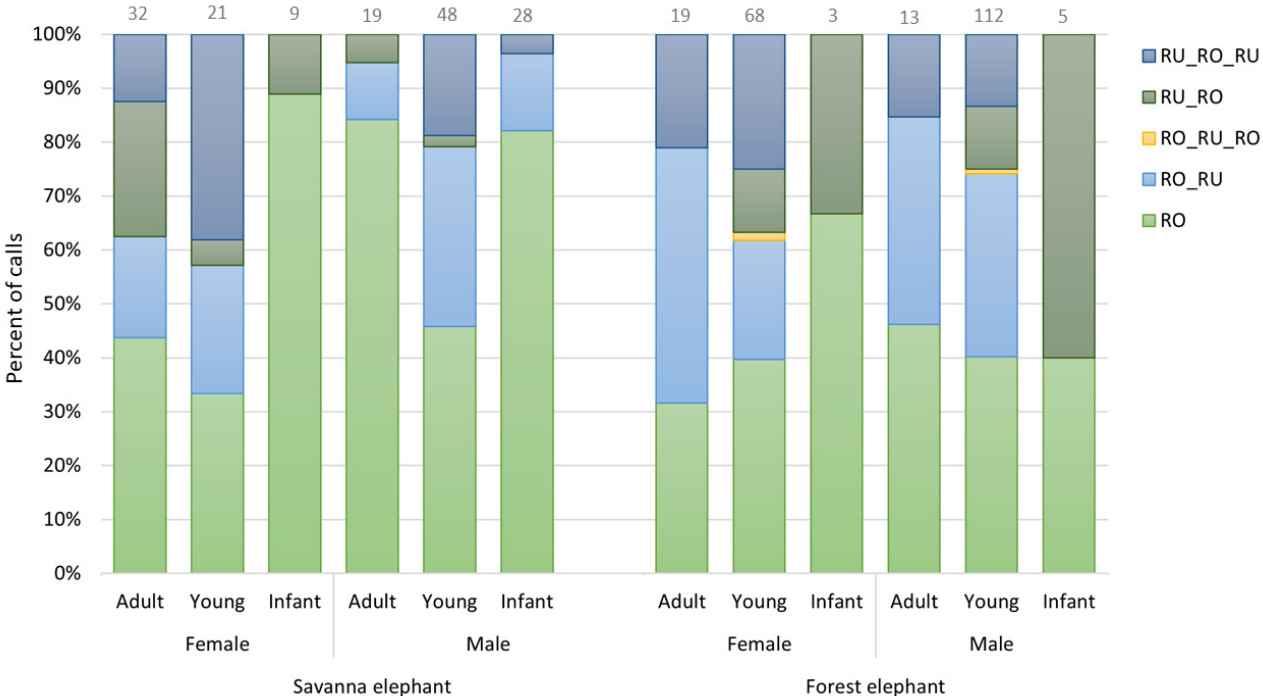
Figure 4. Percent proportion of roars and roar-rumble combinations produced by different age and sex classes of savanna and forest elephants. Numbers above each bar indicate the sample size for the respective age-sex class (savanna elephants: N = 157, forest elephants: N = 220).